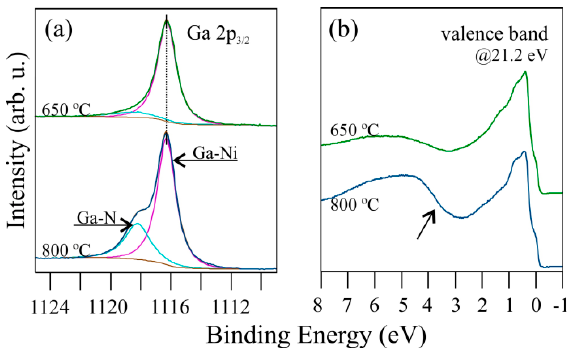
Figure 22. ( a ) XPS spectra of Ga-2p, and ( b ) UPS spectra of the valence band for a Ni-film-covered GaN(0001) surface annealed at 650 and 800 °C. Arrow indicates a visible DOS contribution from GaN. Mean film thickness is 3 nm. Data in ( a ) were previously published in [29]. terns from Ni film annealed at 650 °C show strong, sharp spots corresponding to the Ni(111) ‐ ( √ 3 × √ 3) R 30° structure, with a lattice constant of 2.58 Å, and, after annealing at 800 °C, reveal sharp diffraction spots of the Ni(111) ‐ (2 × 2) and GaN(0001) ‐ (1 × 1) struc ‐ tures. The presence of spots corresponding to GaN(0001) ‐ (1 × 1) shows that further Ni–Ga alloying is accompanied by coalescence and, consequently, the partial opening of the film and the uncovering of the substrate surface, which is consistent with spectroscopic obser ‐ vations. Figure 23. LEED patterns (90 eV) for Ni ‐ film ‐ covered GaN(0001) after annealing at ( a ) 650 and ( b ) 800 °C. The three domains of the square structure of the MnGa alloy and the (1 × 1) hexagonal structure of the GaN(0001) substrate are marked. Mean film thickness is 3 nm. Reprinted with permission from [29]. Copyright 2014 Elsevie. When semiconductors are exposed to photons with a higher energy level than their forbidden gaps, electron–hole pairs are formed. The generation of an electron ‐ hole can also take place in metal/semiconductor systems, especially in the case of thin coating sys ‐ tems [104] and, as a consequence, may result in an appearance of a quasi ‐ Fermi level. Such an effect in the case of Ni film on p ‐ type GaN(0001) was described in [30] and is presented below. Evolutions of the Ga ‐ 3d and Ni ‐ 2p 3/2 core level lines after Ni deposition on a p ‐ type GaN(0001) surface, followed by annealing, are shown in Figure 24. The Ga ‐ 3d peak is lo ‐ cated at a BE of 18.9 eV for the bare p ‐ GaN(0001) surface and shifts towards a higher BE, to the position of 19.6 eV, after Ni film deposition. According to Mn/GaN (Section 3.2), as well as the Ni/ n ‐ GaN systems described above, it is obvious that the shift is related to the Schottky barrier formation. The SBH of Ni on p ‐ GaN for electrons is SBH (cid:2926)(cid:2891)(cid:2911)(cid:2898)(cid:2898)(cid:2919) (cid:3404) E (cid:2917) (cid:3398) VBM (cid:2891)(cid:2911)(cid:2898)(cid:2898)(cid:2919) , and the position of VBM (cid:2891)(cid:2911)(cid:2898)(cid:2898)(cid:2919) = 1.9 eV (based on the Ga ‐ 3d shift), which gives SBH = 1.5 eV. The value of 1.9 eV is the magnitude of SBH for holes.